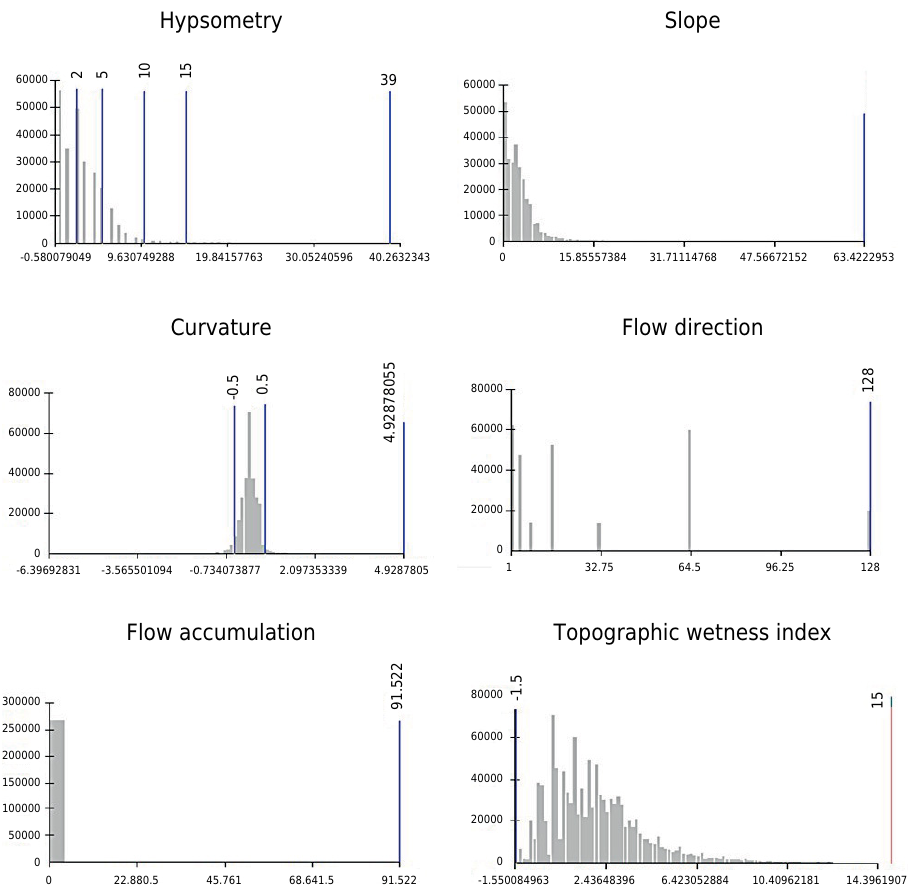
Figure 3. Frequency histogram of the geomorphometric